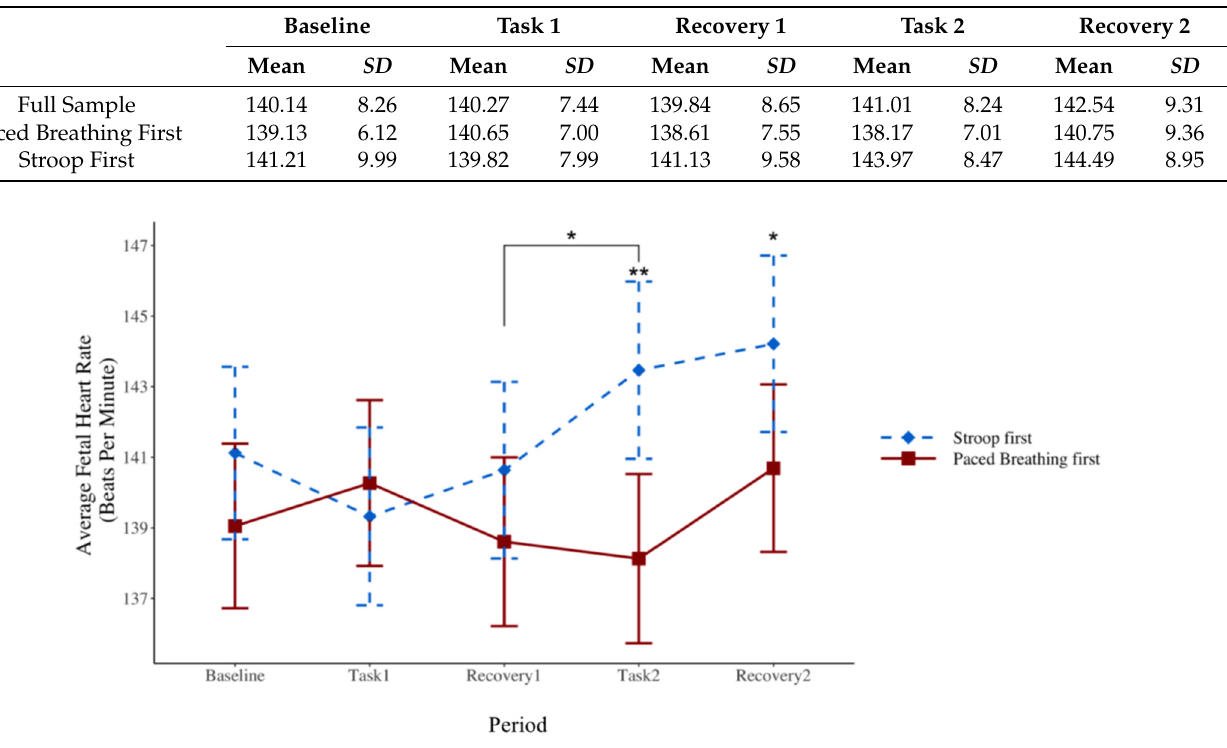
Figure 4. Maternal HR During Each Study Period By